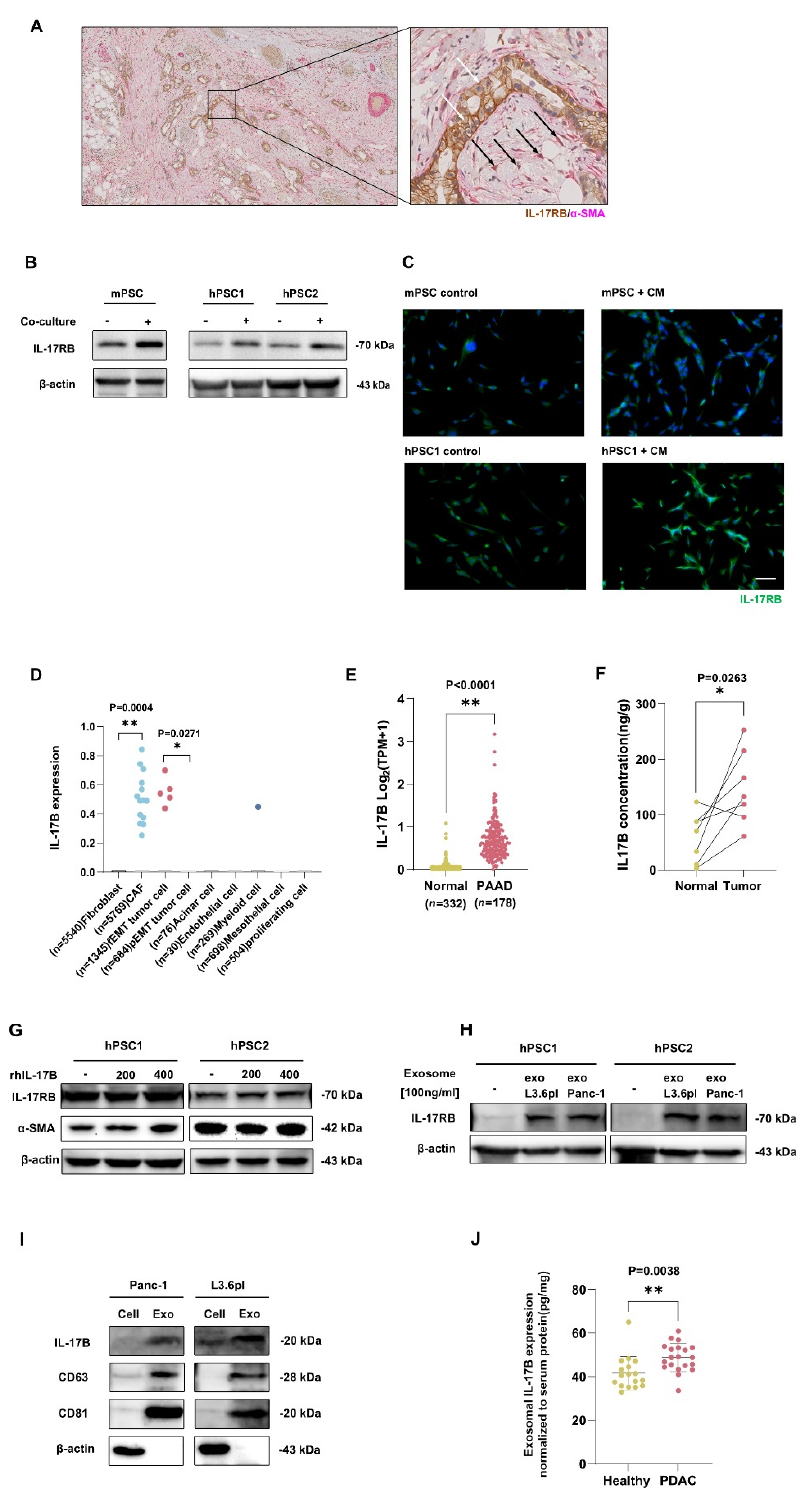
Figure 1. Expression of IL-17RB in PDAC tumors and stroma from humans and mice. ( A ) Double-immunohistolochemistry staining of IL-17RB (brown) and α -SMA. White arrows point to IL-17RB positive tumor cells. Black arrows depict double-positive stromal cells. Scale bars = 100 μ m; ( B ) Murine PSCs express more IL-17RB after co-culture with Panc02 pancreatic cancer cells than naive PSCs (left). Two human primary PSCs preparations (hPSC1 and hPSC2) express more IL-17RB after co-culture with L3.6pl pancreatic cancer cells than naive PSCs (right). Western blots of mouse PSCs (RLT-PSCs) and two primary human PSC preparations from surgical specimens. Data show typical images from three independent experiments; ( C )